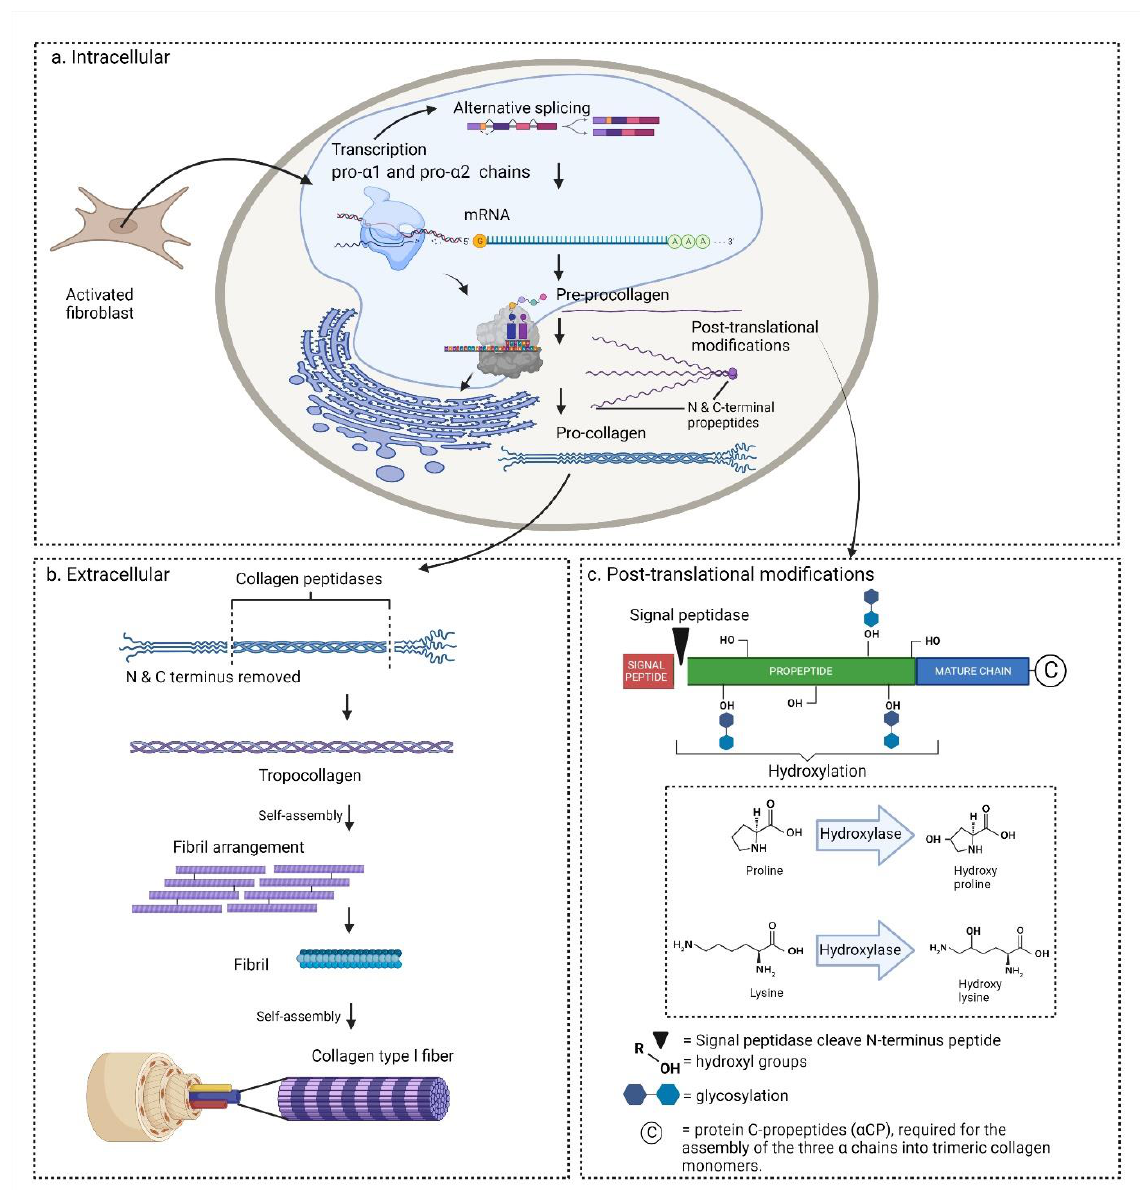
Figure 2. Overview of collagen type I biosynthesis from ( a ) intracellular transcription to ( b ) formation of extracellular complex macromolecular structures and what happens in between during ( c ) post- translational